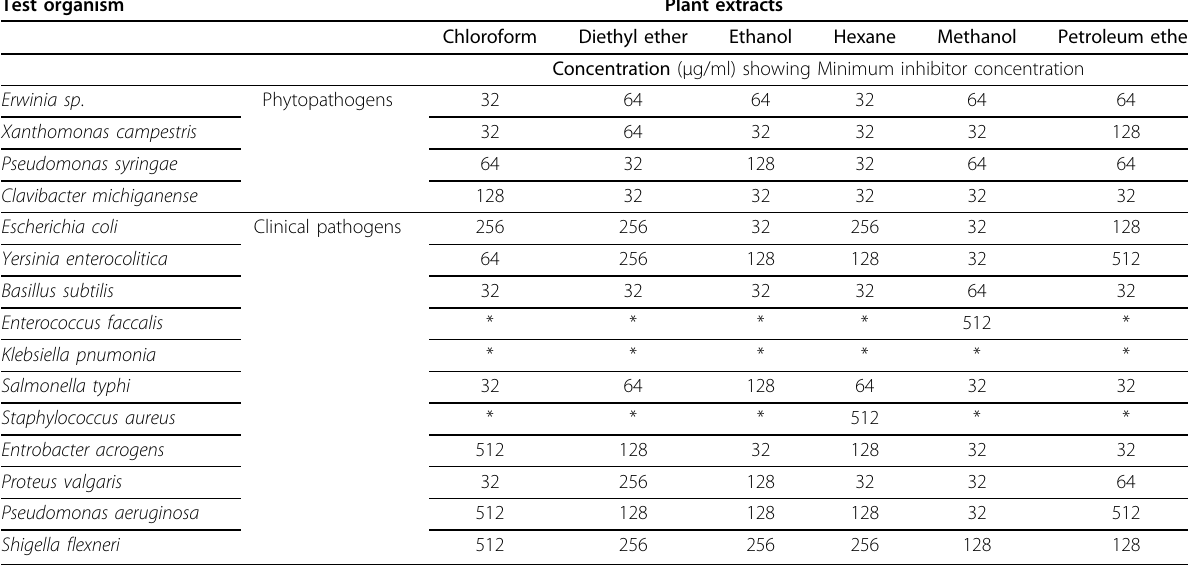
Table 2 Minimum inhibitory concentration (MIC) of various solvent extracts of A. nilagirica (% v/v) against micro- organisms Test organism